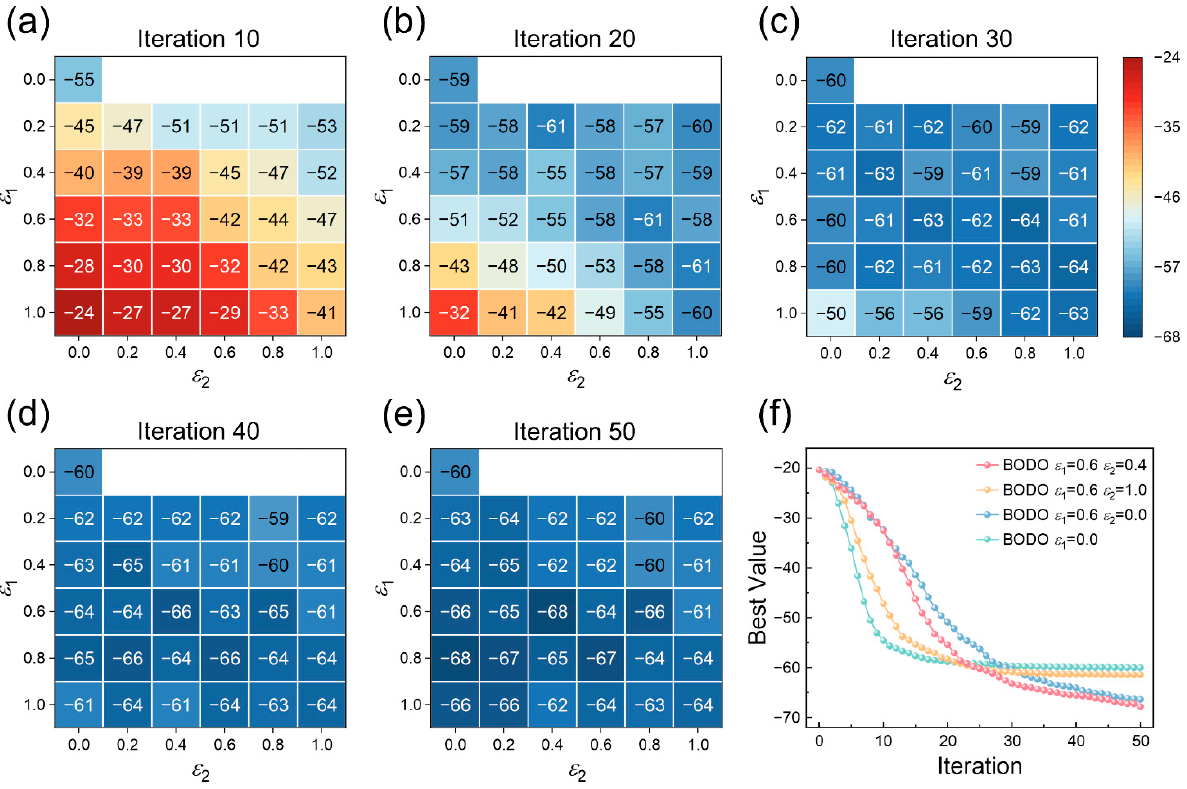
Figure 3. The average optimization results on alpine2 5d . ( a – e ) The heatmap of best values of BODO with different 𝜀 (cid:2869) and 𝜀 (cid:2870) settings at iterations 10, 20, 30, 40, and 50, respectively. ( f ) The best value comparison of BODO ( 𝜀 (cid:2869) = 0.6 , 𝜀 (cid:2870) = 0.4 ) with its counterparts that include only the LP D-optimal branch ( 𝜀 (cid:2869) = 0.6 , 𝜀 (cid:2870) = 1.0 ), only the random selection D-optimal branch ( 𝜀 (cid:2869) = 0.6 , 𝜀 (cid:2870) = 0.0 ), and no D-optimal branch ( 𝜀 (cid:2869) = 0.0 ).